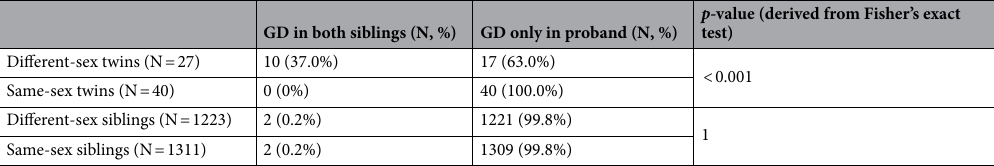
Table 2. Gender dysphoria (GD) in twin and non-twin siblings to probands of same or different assigned sex.